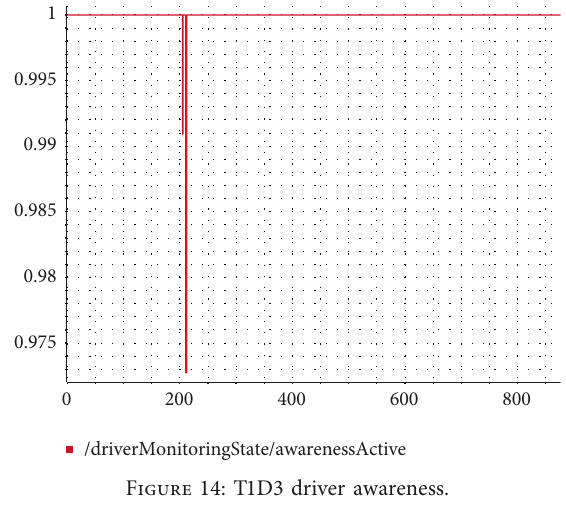
Figure 14: T1D3 driver awareness.